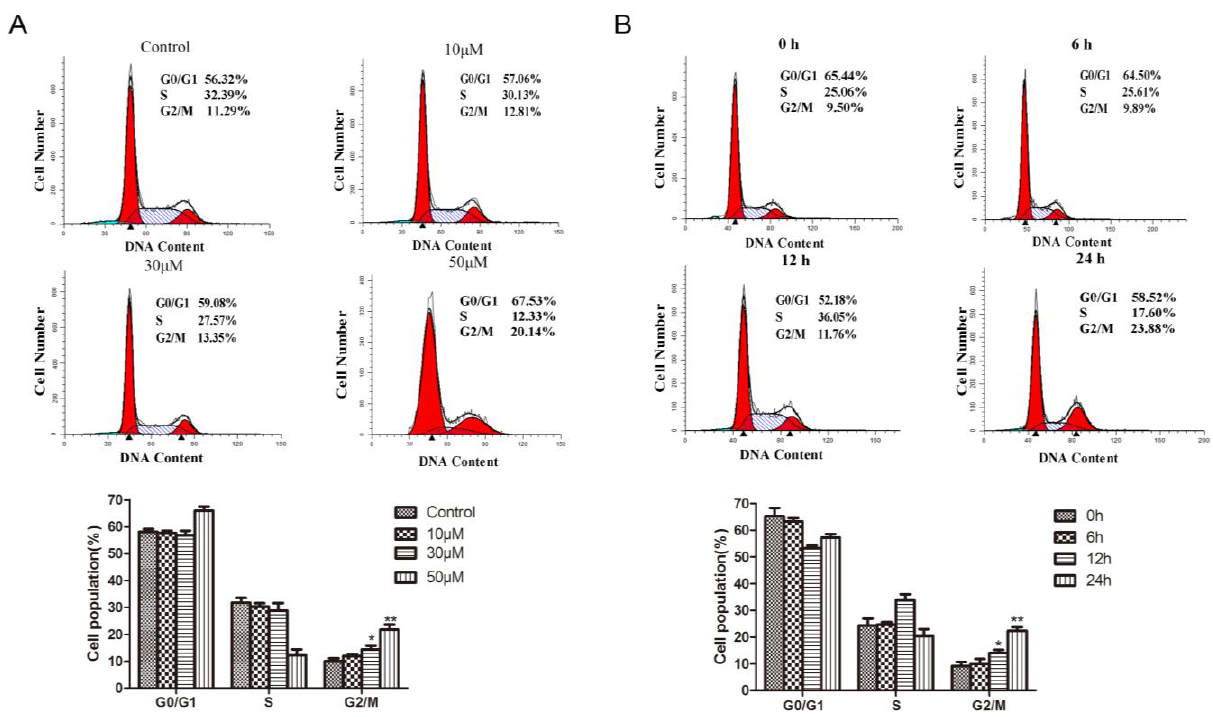
Figure 4. Methyl Sartortuoate causes cell cycle G2/M arrest in human colon cancer LoVo cells. LoVo cells were plated overnight and subsequently treated with Methyl